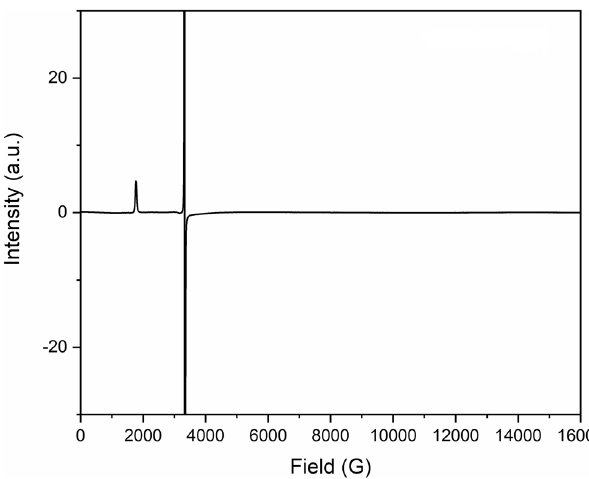
Fig. 6 X-band EPR (9.44 GHz) spectrum of solid crude product from the conversion of 2K to 4K and 6K. The signal at g = 3.74 corresponds to 4K and the one at g = 2.0023 is characteristic of the benzene radical anion (linewidth 14